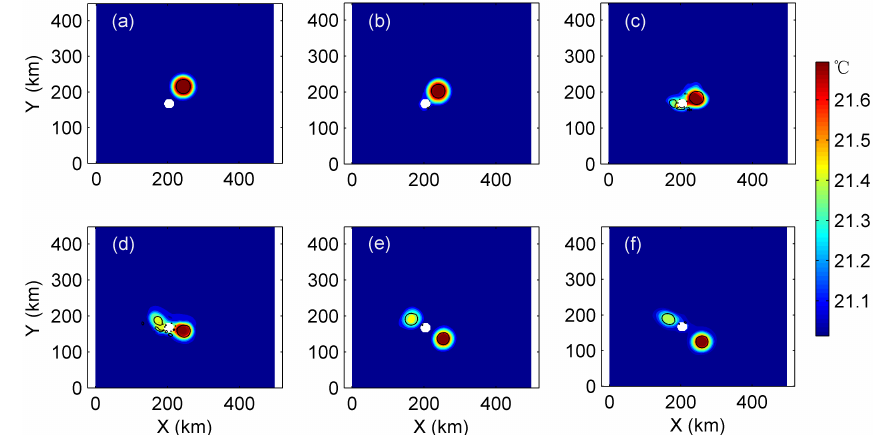
Figure 4. The process of eddy-splitting induced by the interaction with an island of 20km in diameter over 50 days. A time series of snapshots of temperature at 100m depth is shown in colour. (a) The initial state, (b) 10 days, (c) 20 days, (d) 30 days, (e) 40 days and (f) 50 days. The black solid lines are the O – W parameter with a value of − 0.2 σ w